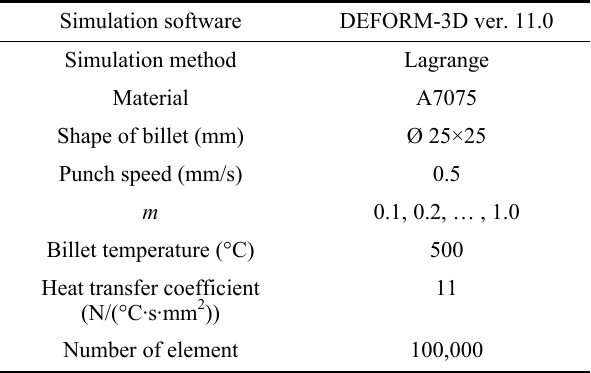
Table 4 Simulation conditions of hot forward–backward extrusion test.